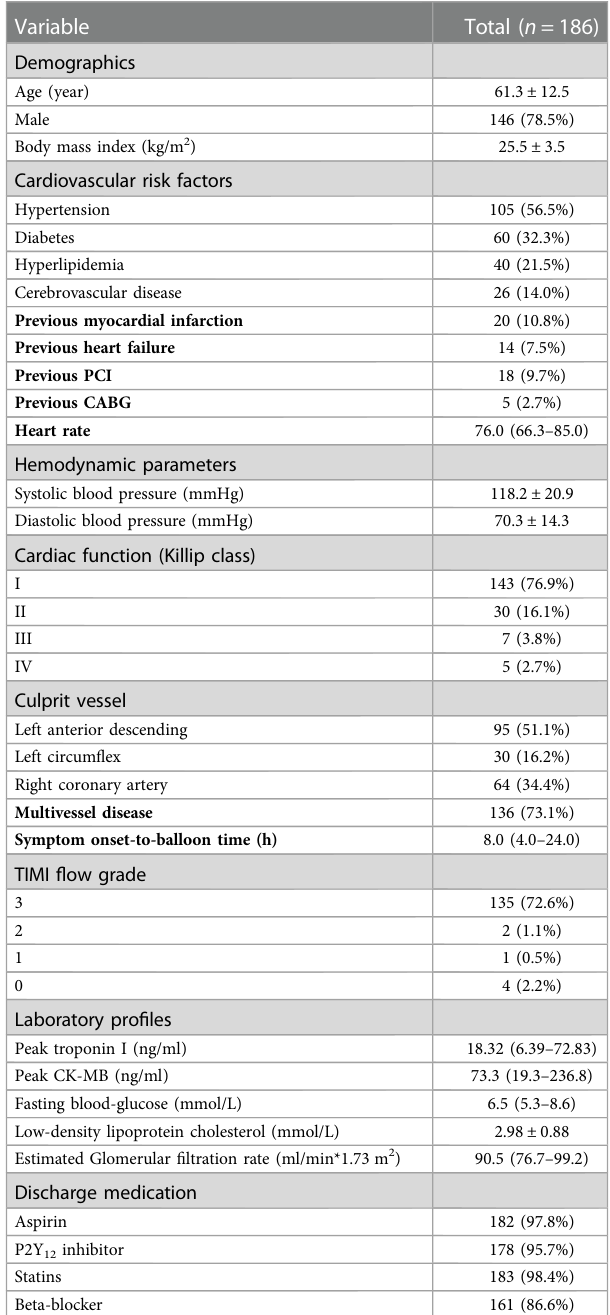
TABLE 1 Baseline clinical